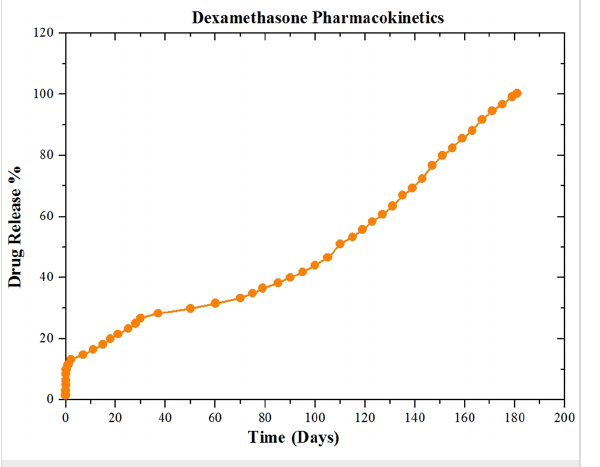
Figure 7: In vitro release of dexamethasone.